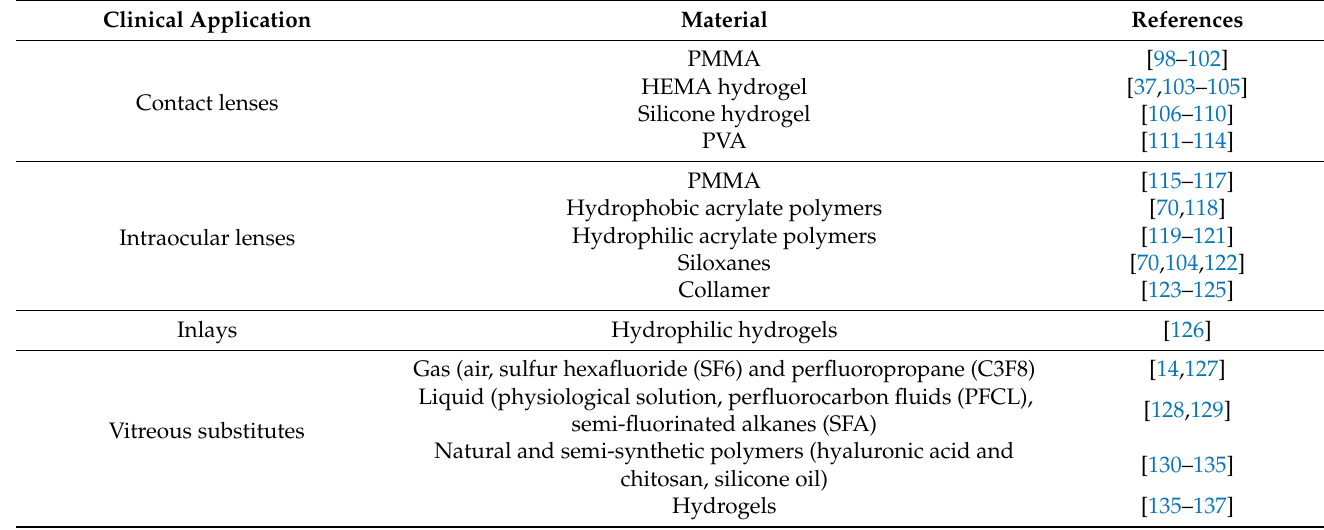
Table 3. Main classes of ophthalmic applications involving